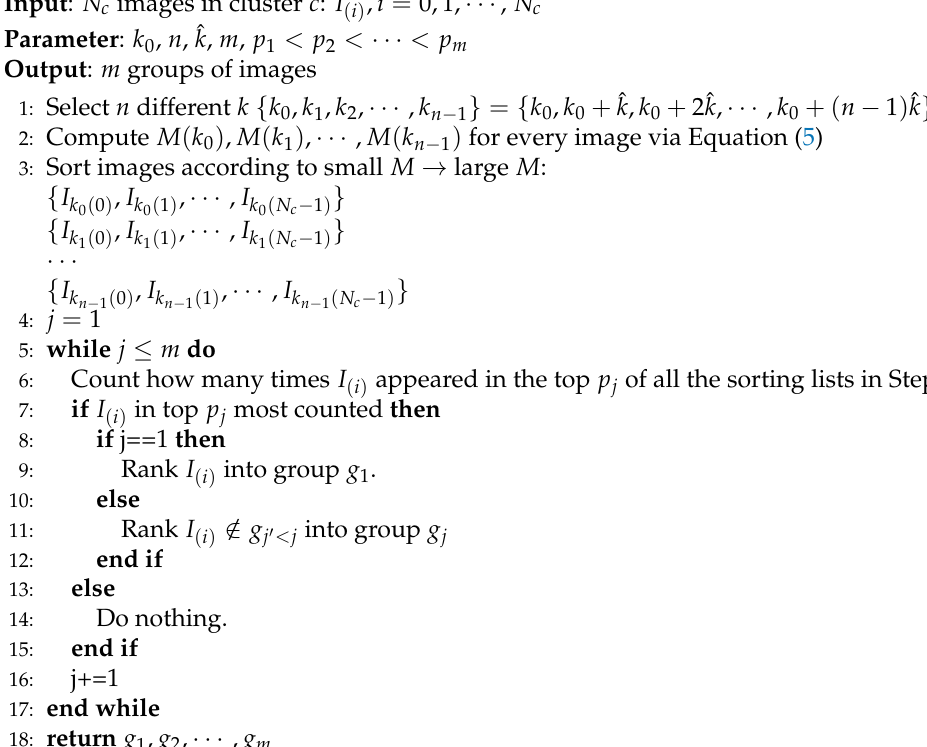
Algorithm 1 Sample ranking and robust majority voting